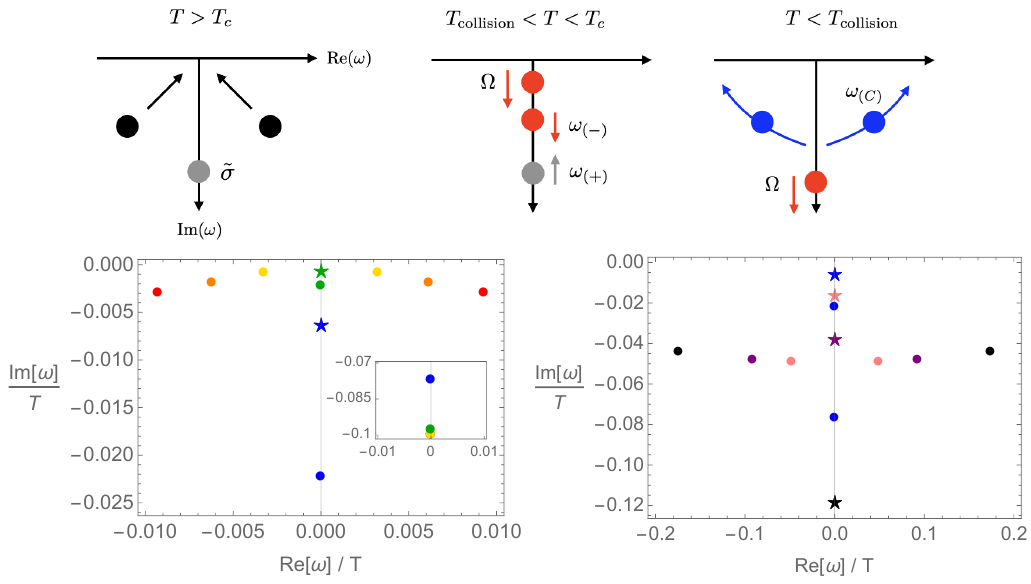
Figure 10 . Top panel: Schematic plot of the poles in the longitudinal channel at zero momentum. In the normal phase, the black symbols represent the scalar fluctuations ( δσ, δη ), while the gray symbol is the damped charge diffusion from ( δa ) . Below T , the scalar sector couples to the x , δa t c gauge sector and three damped poles appear ( Ω , ω ). As the temperature is lowered, the , ω (+) ( − ) pole collides with ω and generates a coupled of complex modes (blue symbols). The other ω (+) ( − ) pole Ω becomes more and more overdamped. Bottom panel: the numerical data. Bottom left: the near critical region, T/T = 1 . 001 − 0 . 999 (red-blue). The ω poles are represented with circles c ( ± ) while the Ω one with stars. The inset shows the behavior of ω pole. Bottom right: the collision (+) regime, T/T = 0 . 999 − 0 . 989 (blue, pink, purple, black). The ω poles (circles) collide on the real c ( ± ) axes, while the Ω pole (star) moves down along the imaginary